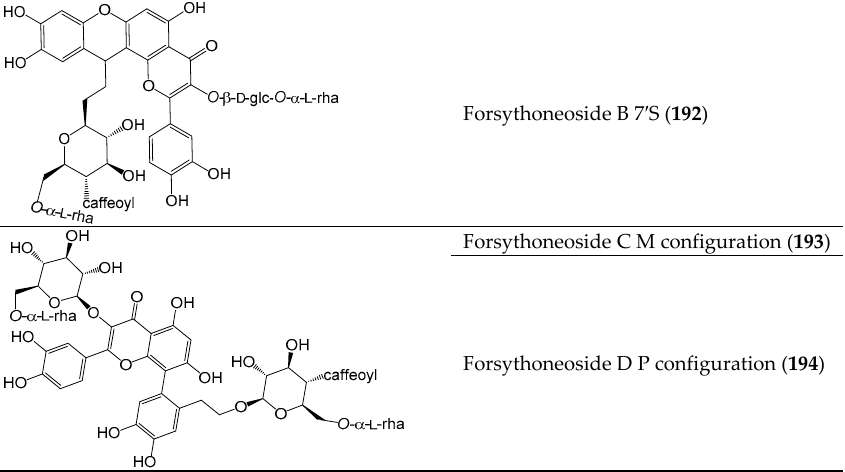
Figure 6. Chemical structures of flavonoids in Forsythiae Fructus.